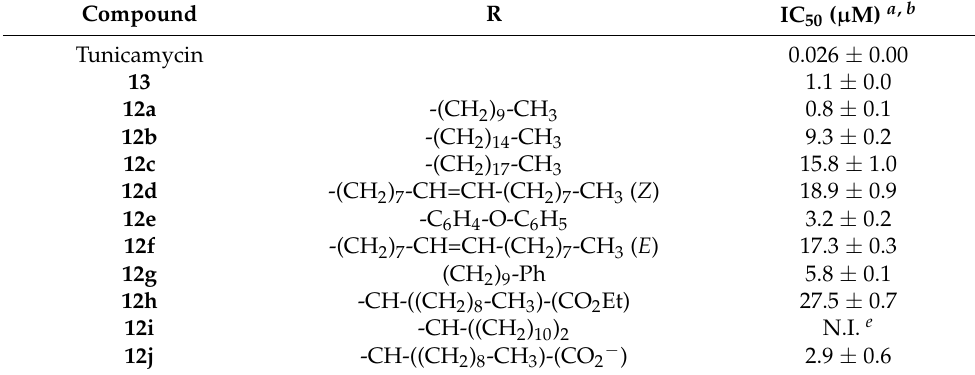
Table 4. Inhibitory activity of compounds 12a–12j against MraY AA .